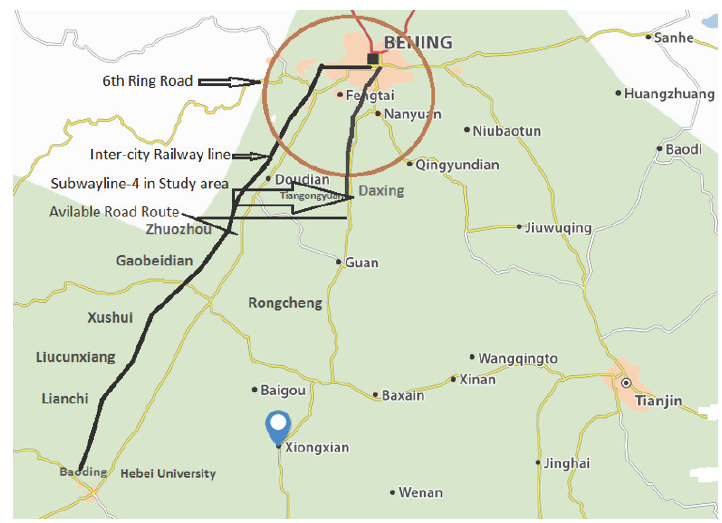
Figure 3: Beijing to Baoding Existing Transportation Network (near